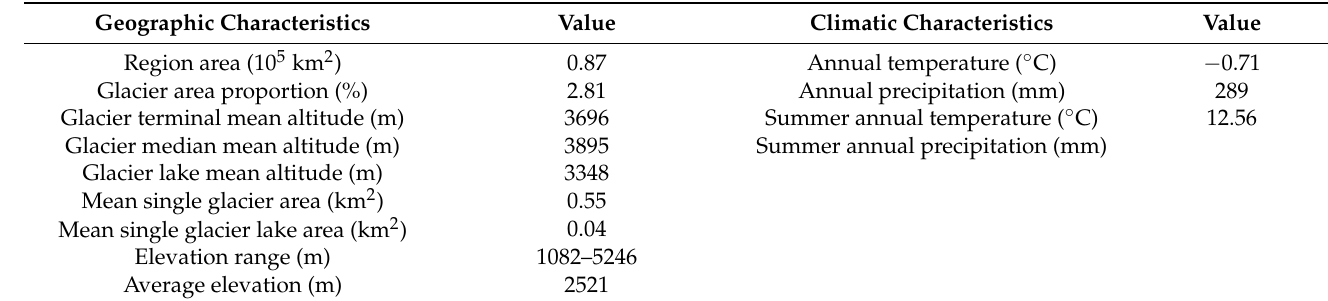
Table 1. Geographic characteristics of the northern Tien Shan, Central